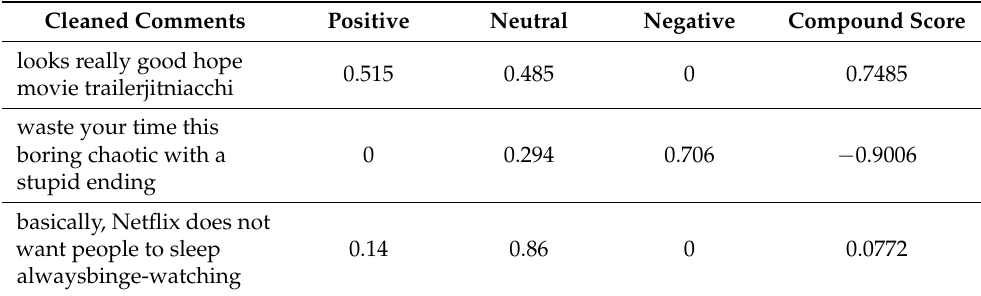
Table 4. Values of four parameters of some example comments.